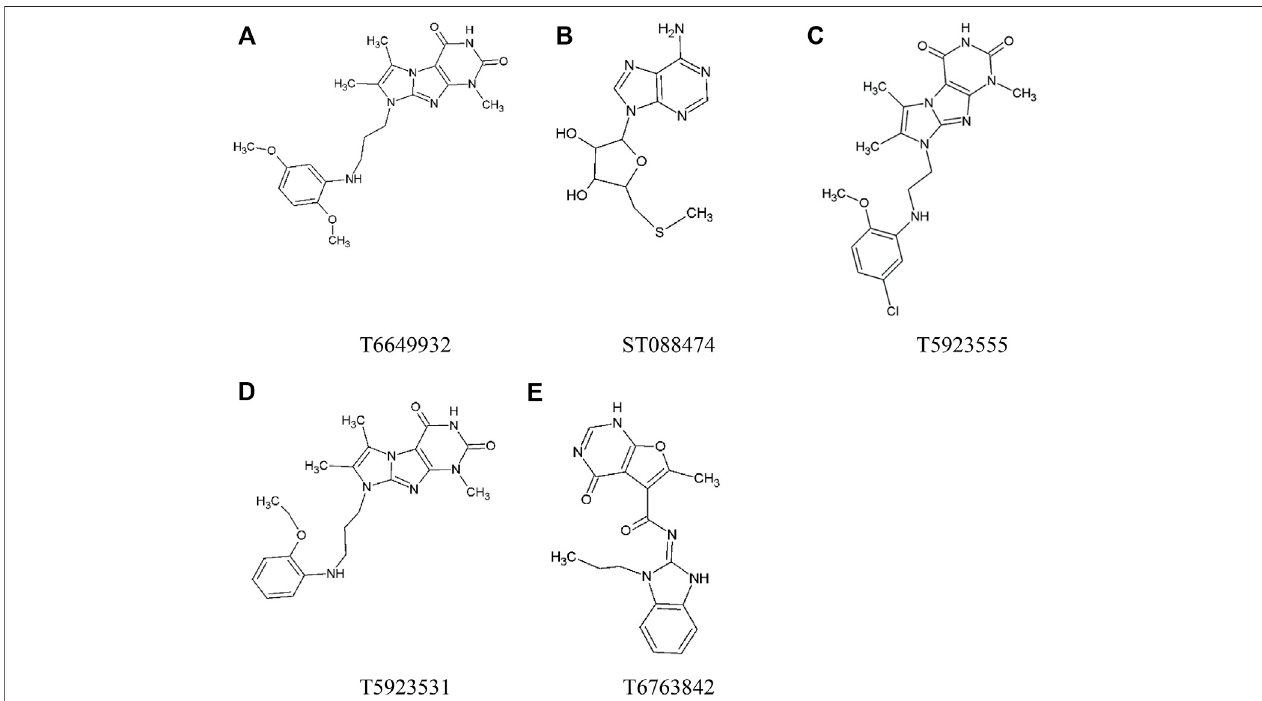
FIGURE 3 | The chemical structure of selected lead compounds. (A) T6649932, (B) ST088474, (C) T5923555, (D) T5923531, and (E) T6763842.